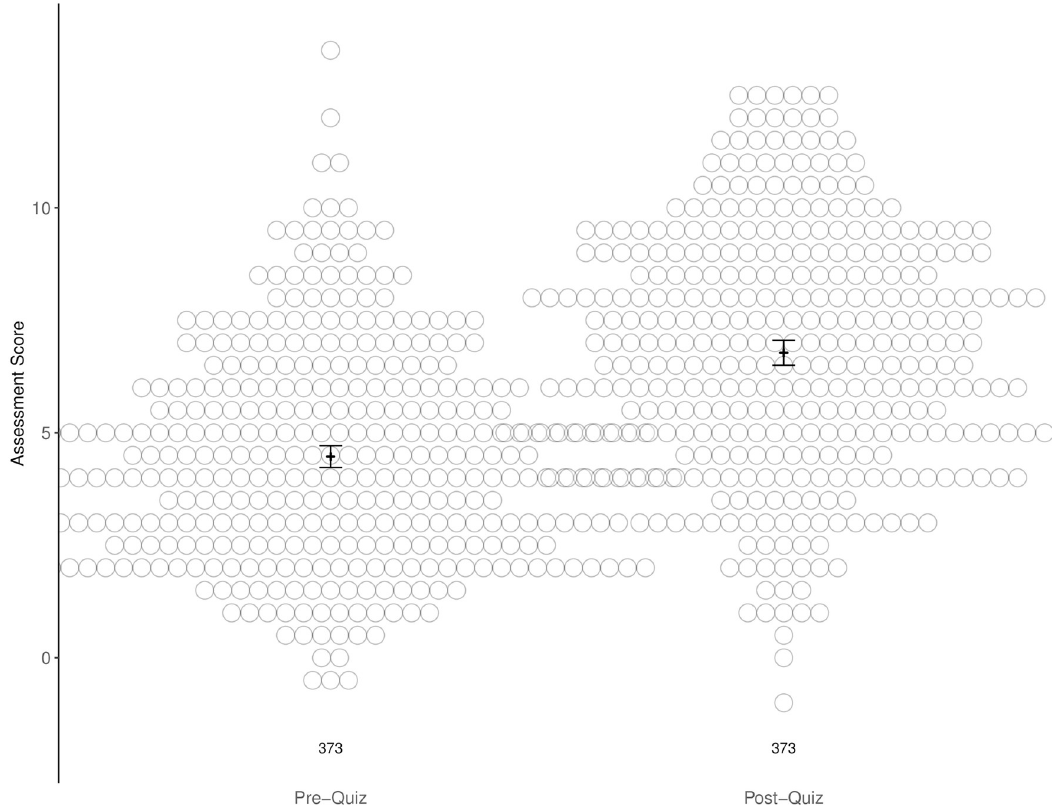
Fig 2. Aggregate pre-/post-assessment quiz scores indicate significant participant learning gains. The fifteen-item assessment consisting of a combination of multiple-choice and multiple-select questions was administered pre- and post-completion of the learning modules. Nine cohorts of student participants (n = 373) at independent institutions completed the assessment instrument with 7–28 days between pre- and post-assessment. Pre- (4.47) and post- (6.78) means are represented by a narrow black crossbar. The difference between the pre- and post-means has statistical significance (p < 0.00001, GLM). Black error bars represent the 95% confidence interval of the mean and the number of matched student assessment records is indicated below each swarm plot.